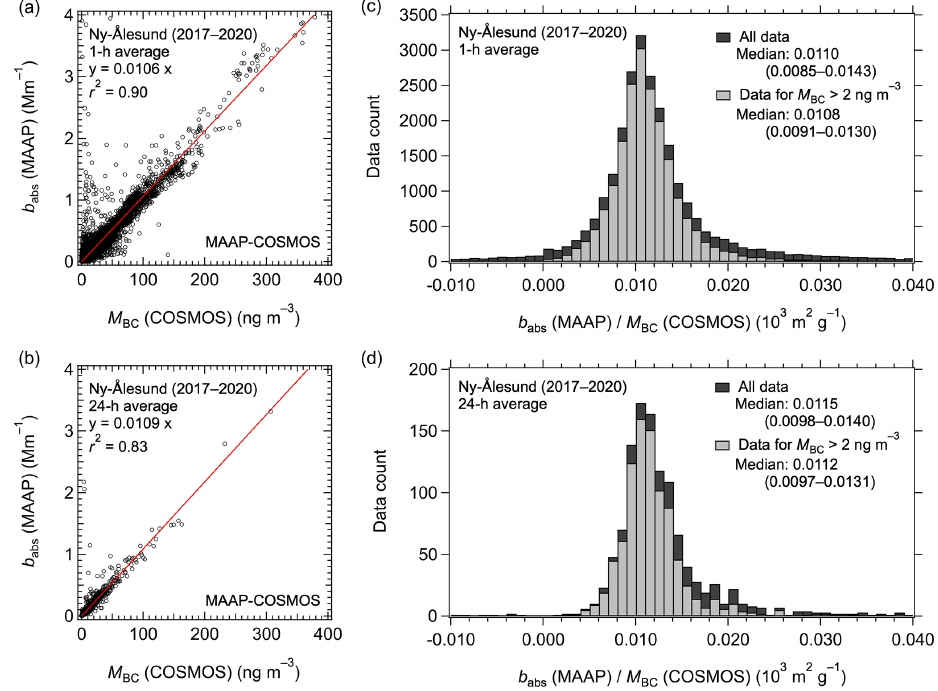
Figure 9. Correlations of M BC (COSMOS) and b abs (MAAP; λ = 637nm) from January 2017 to December 2020 at Ny-Ålesund for (a) 1h averaged and (b) 24h averaged data. The solid red lines are the least-squares regressions forced through the origin. (c, d) Corresponding histograms of b abs (MAAP) /M BC (COSMOS) ratios for all data and data with M BC (COSMOS) > 2ngm − 3